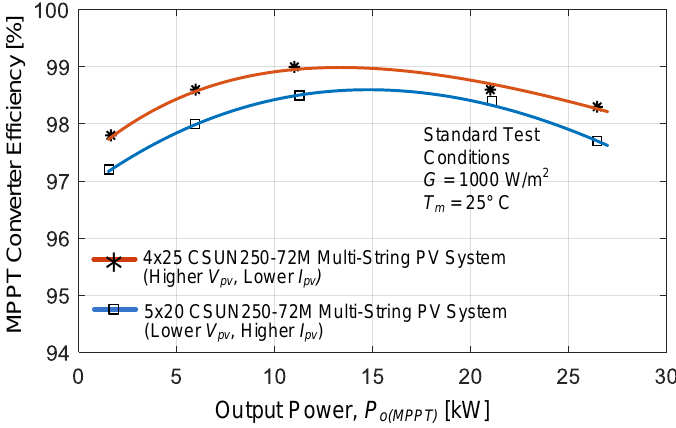
Figure 32. Effects of the configuration of multi-string PV system on the efficiency of MPPT converter with HF link in Figure 3 (Simulation results).